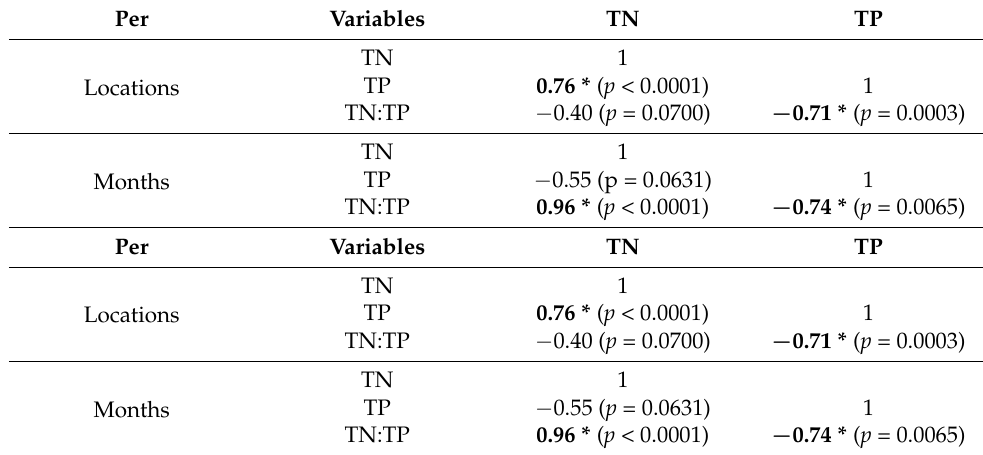
Table 5. Pearson correlation